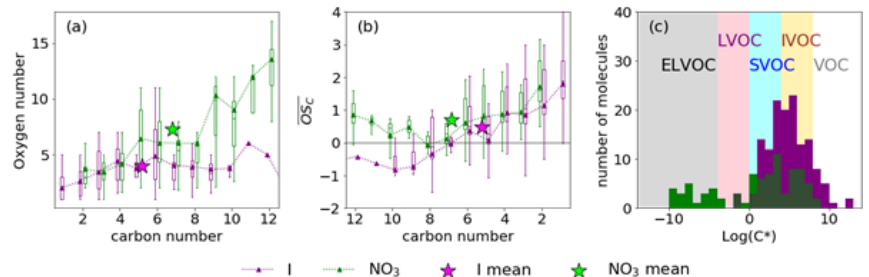
Figure 4. Comparison of organic oxidation products from the iodide (purple) and nitrate (green) ionisation schemes. (a) Carbon number vs. oxygen number. (b) Average carbon oxidation state ( OS C ) vs. carbon number. (c) Saturation concentration (C*) based on Mohr et al.